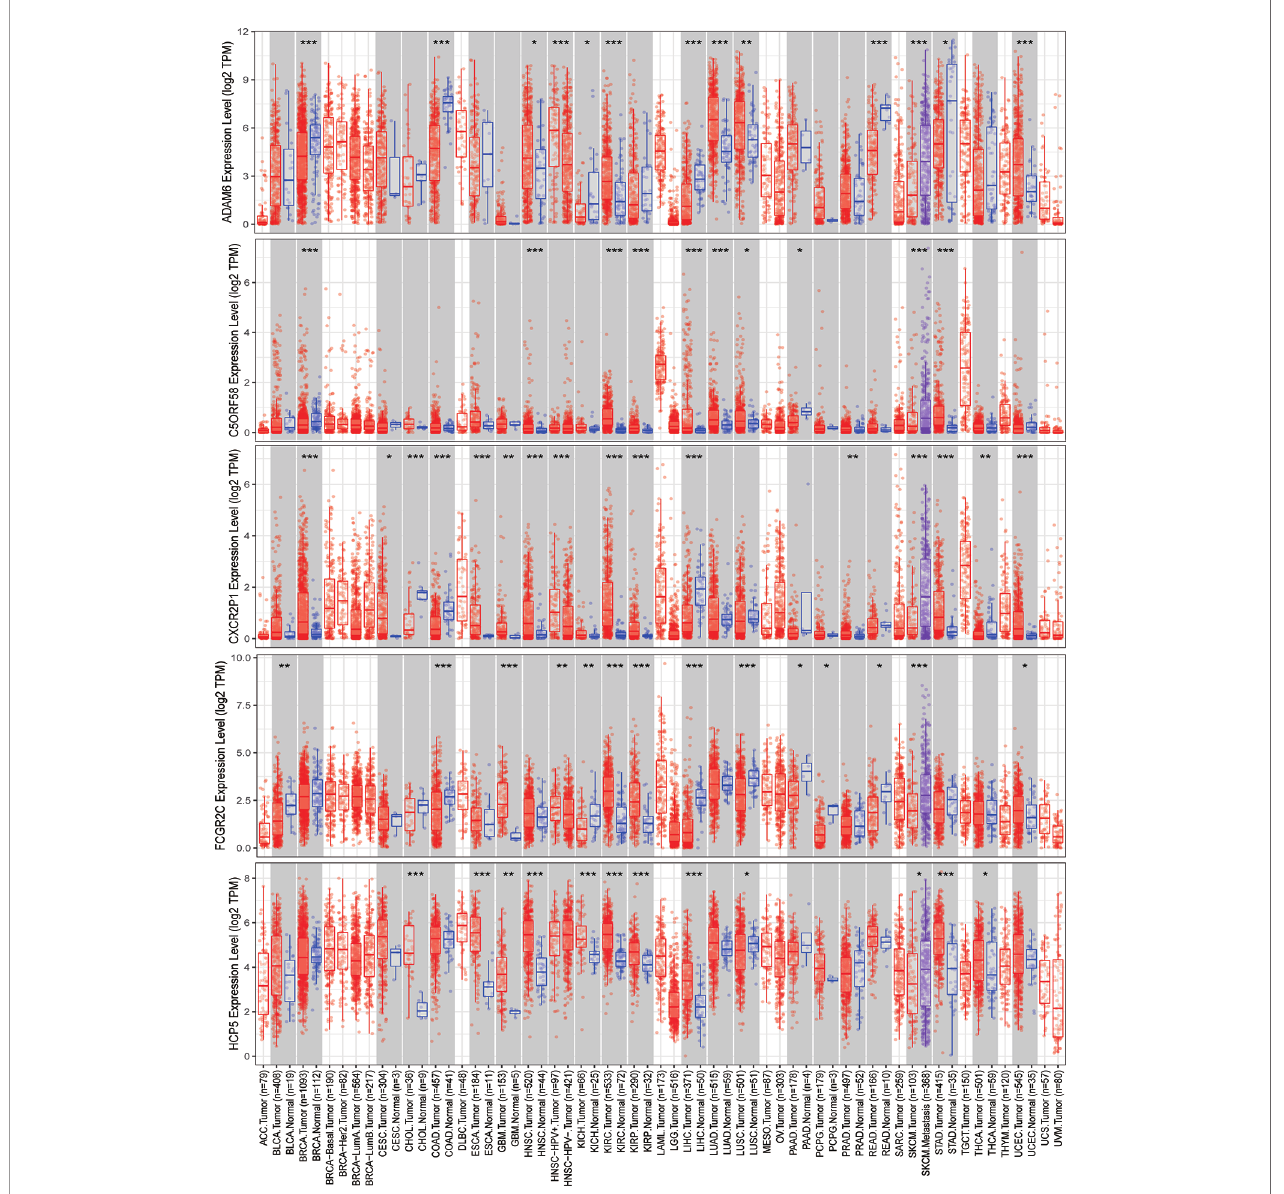
FIGURE 2 | Expression of ADAM6, C5orf58, CXCR2P1, FCGR2C, and HCP5 in different human cancer tissues and adjacent normal tissues. *P < 0.05; **P < 0.01; ***P <